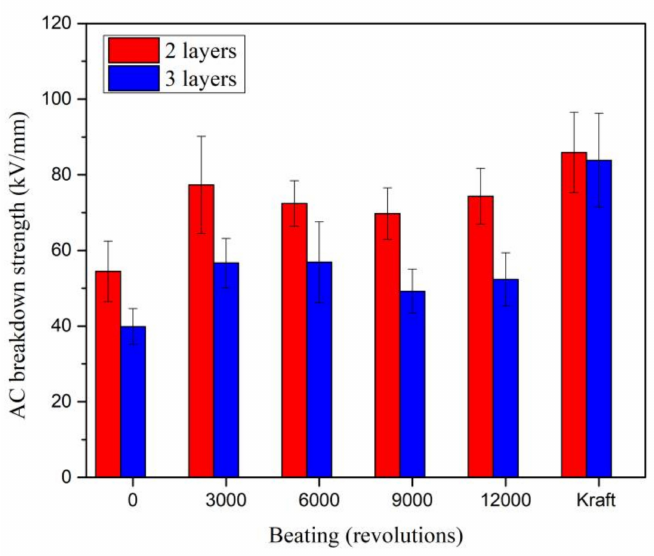
Figure 23. AC breakdown strength of Kenaf and Kraft papers at di ff erent layers and beating